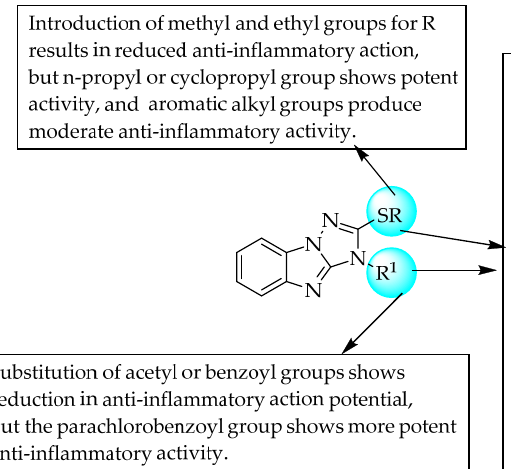
Figure 47. SARs of 1,2,4-triazolobenzimidazoles. Soni et al. (2011) reported the anti-inflammatory activity of N-substituted benzimida- zole derivatives at doses of 200 mg/kg p.o. in the carrageenan-induced model of inflamma- tion/oedema in rat hind paws. One of the synthesised compounds, 1-[1 H -benzimidazol-1- yl(phenyl)methyl]-5-methyl-2-phenyl-1,2-dihydro-3 H -pyrazol-3-one, showed a higher log P value and anti-inflammatory activity (75.0, maximum % reduction in oedema) than cele- coxib (83.3, maximum % reduction in oedema). As shown in Figure 48, a 2-aryl substitution at the 5-methyl-substituted pyrazol-3-one at the benzimidazole-1-yl methyl moiety en- hanced the anti-inflammatory activity, whereas an amide substitution in the same position resulted in moderate activity [72].